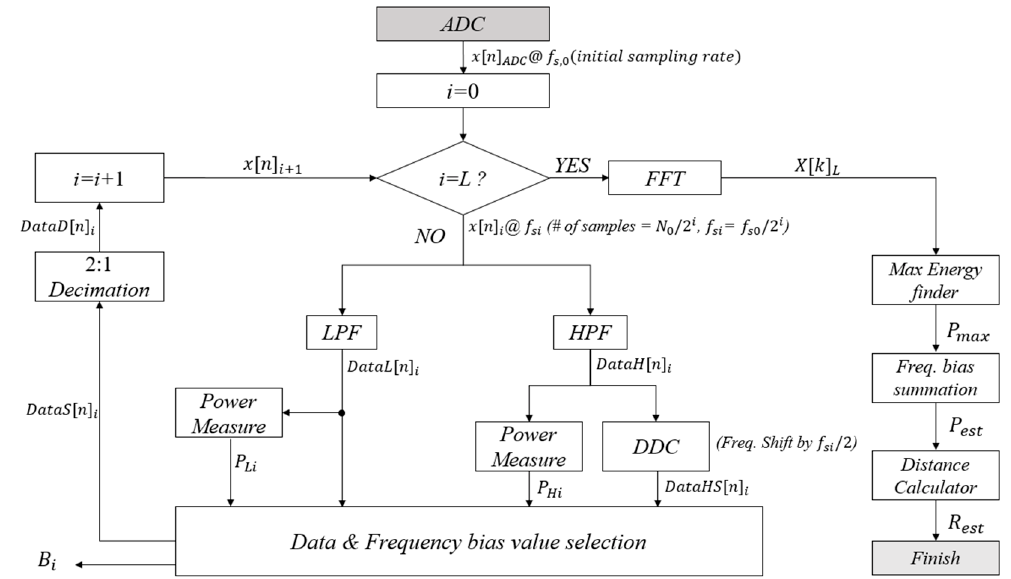
Figure 3. Proposed DDC FMCW LiDAR System’s Flow Chart.